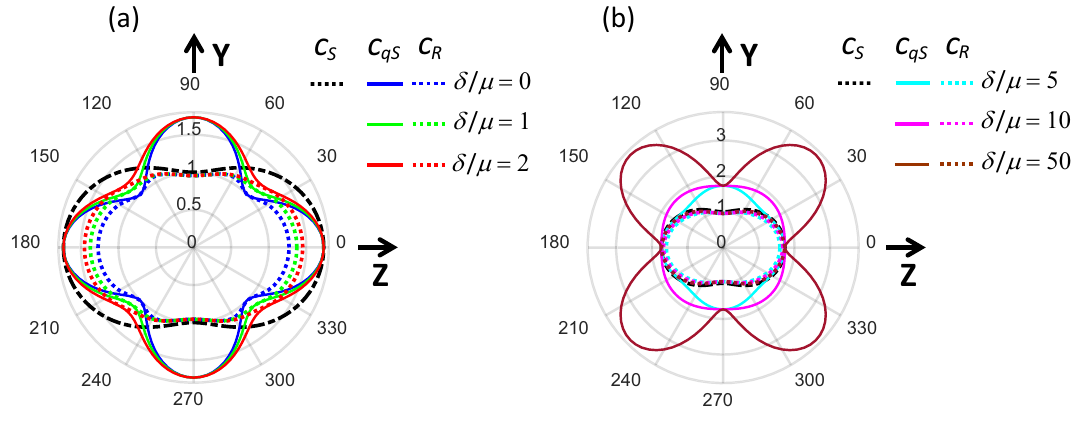
Figure 1. Anisotropy of phase velocity for bulk shear (black dashed line), quasi-shear (solid lines) and surface Rayleigh (dotted lines) waves in a fast-axis NITI medium. ( a ) δ/µ < 2 , ( b ) δ/µ > 5 . In both panels G /µ = 3